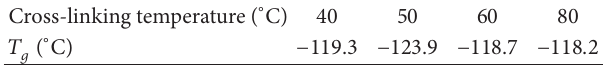
Table 2: Cross-linking effect on the glass transition tempera- tures ( 𝑇 𝑔 ) of PDMS-VTOS membranes (the weight ratio of H- PDMS: VTES:DBTDL is 1:0.2 :0.02).